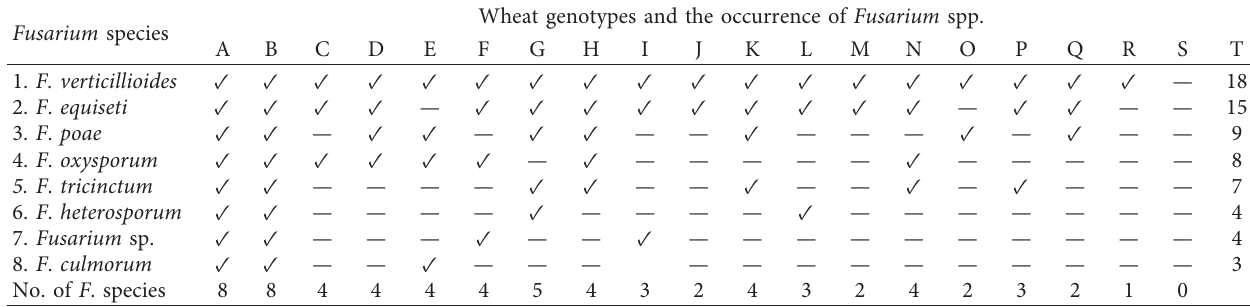
Table 3: Pathogenic Fusarium spp. diversity in genotypes of wheat seeds in three Rift Valley regions, Kenya. Wheat genotypes and the occurrence of Fusarium Fusarium species